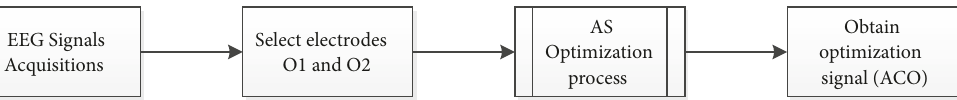
Figure 10: Proposed method.